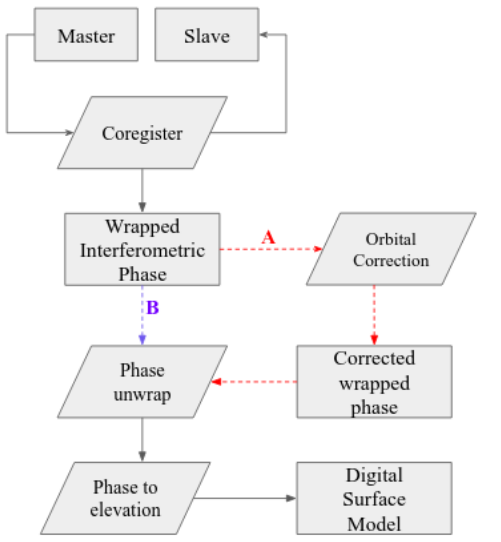
Figure 5. General workflow followed to assess the impact of the orbital correction module. The dotted lines indicate the two alternative approaches: Process with orbital correction (A), or with no orbital correction (B).